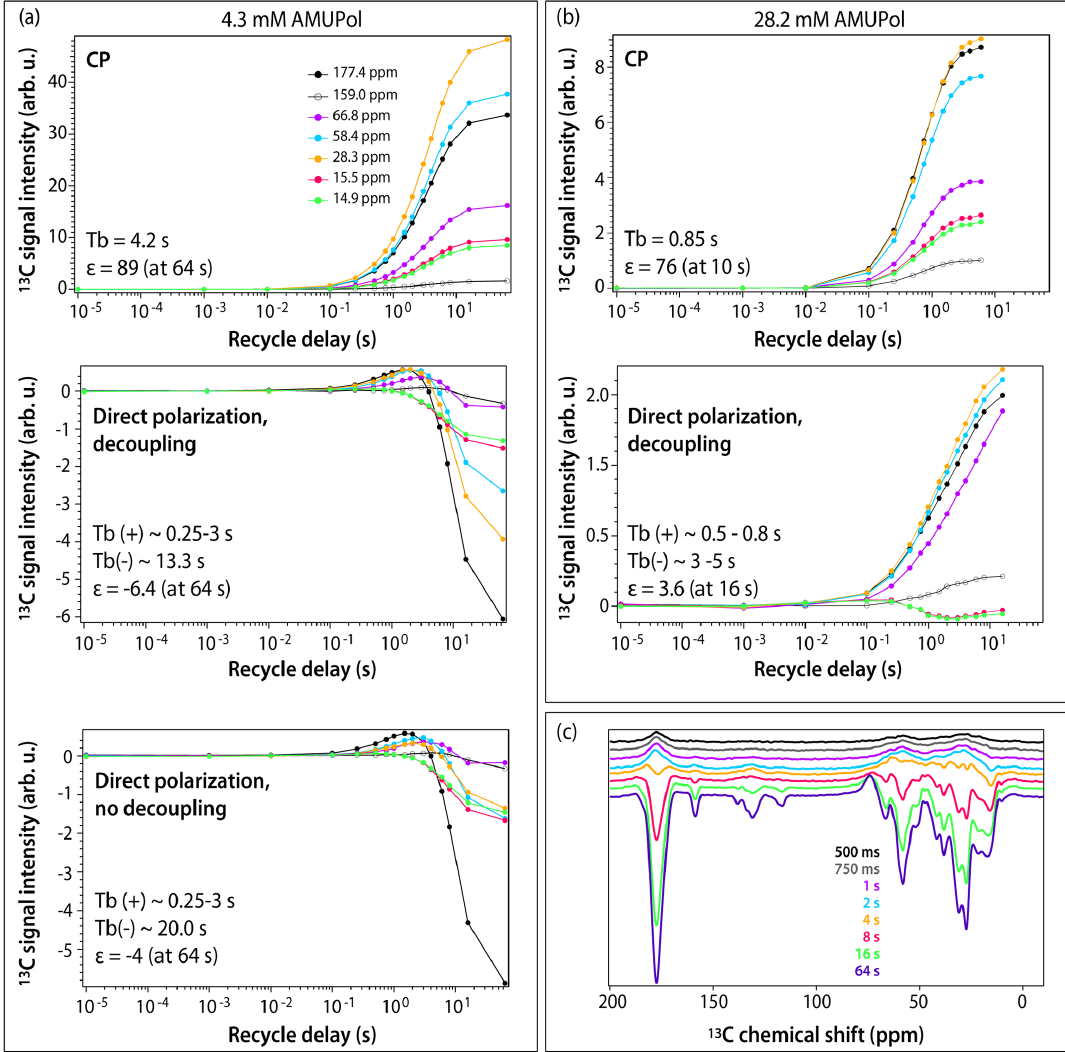
Figure 3. DNP buildup profiles for 13 C signals in DNP-enhanced spectra of 5F-Trp, U- 13 C, 15 N CA tubular assemblies containing (a) 4.3mM AMUPol and (b) 28.2mM AMUPol. (a) Top, CPMAS spectra; middle, direct polarization spectra acquired with decoupling; bottom, direct polarization spectra acquired without decoupling. Signals corresponding to different functional groups are color-coded with the corresponding chemical shifts displayed in the topmost panel: carbonyl (177.4ppm, black filled circles), aromatic (159.0ppm, black open circles), C α (66.8ppm, magenta, 58.4ppm, blue), C β /C γ (28.3ppm, gold), and Ile methyl groups (15.5ppm, red, 14.9ppm, green). The ex- perimental buildup time constants ( T B ) and the maximum signal enhancements ( ε ) are indicated in each panel. (c) DNP-enhanced DPMAS spectra of 5F-Trp, U- 13 C, 15 N CA tubular assemblies containing 4.3mM AMUPol recorded with different recycle delays: 500ms (blue), 750ms (grey), 1s (magenta), 2s (blue), 4s (gold), 8s (red), 16s (green), 64s (purple). The spectra were acquired at 14.1T (150.96MHz 13 C Larmor frequency) at a MAS frequency of 24kHz and 120K sample